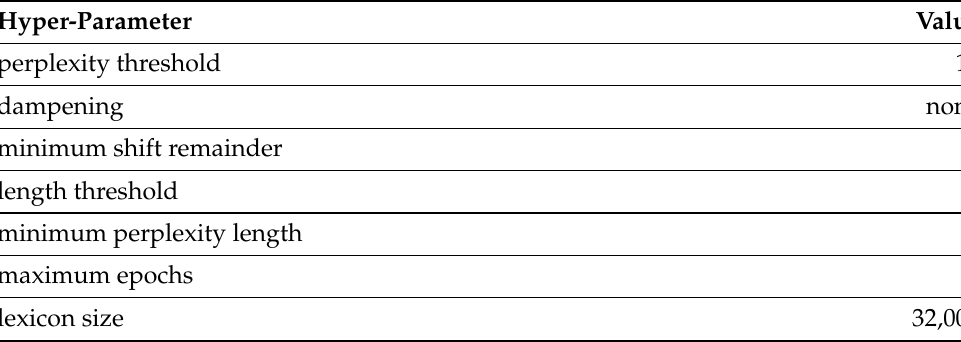
Table A4. Hyper-parameters for training LMVR models.